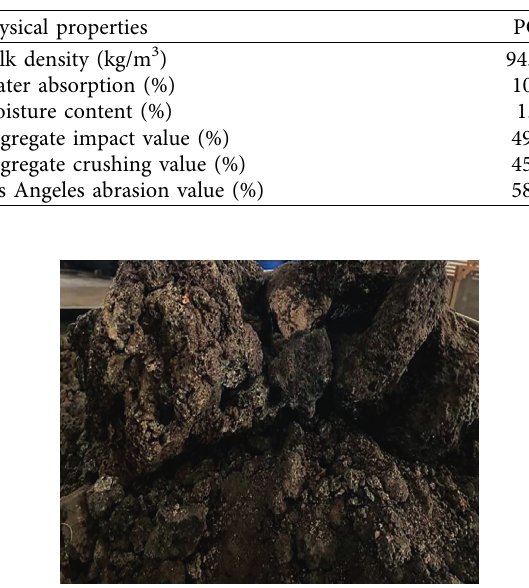
Table 1: Physical properties of POC.